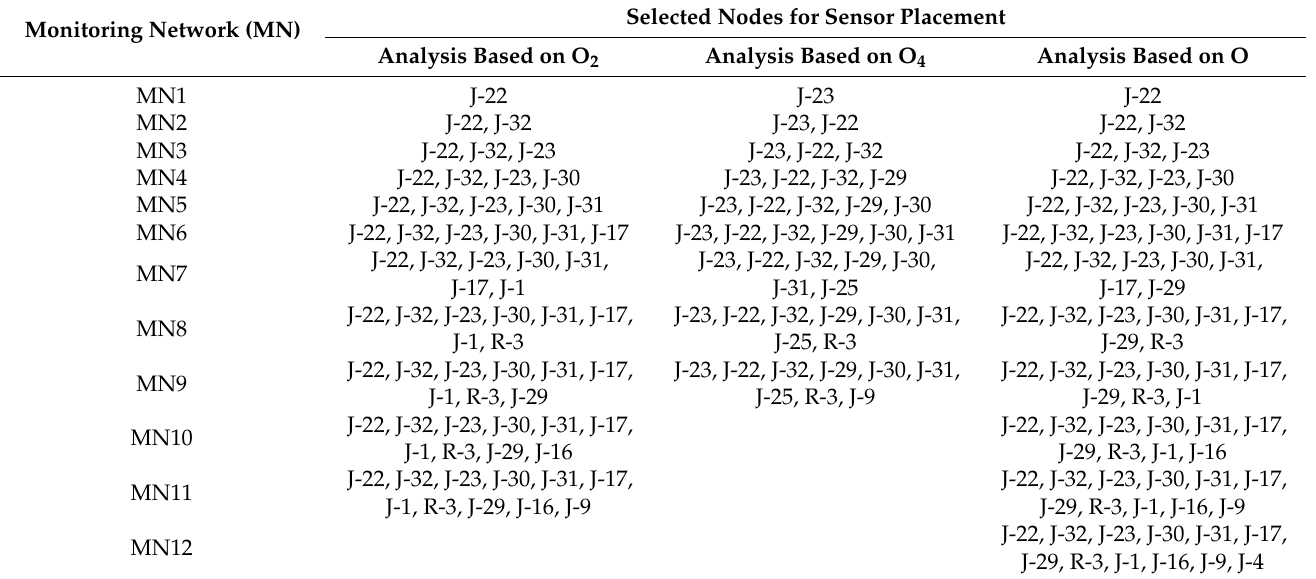
Table 4. The monitoring networks and the selected nodes for sensor placement for each monitoring network for three cases based on different objectives: O 2 , O 4 and